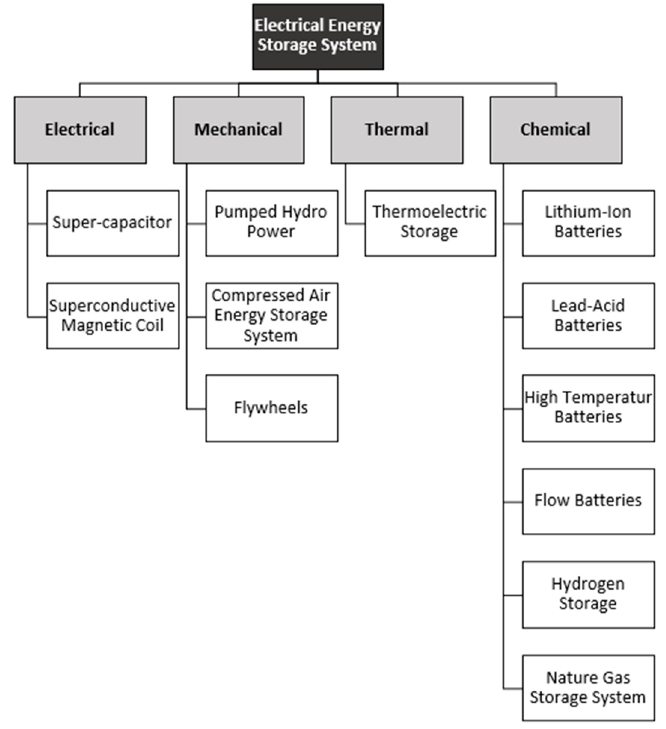
Figure 1. Energy storage